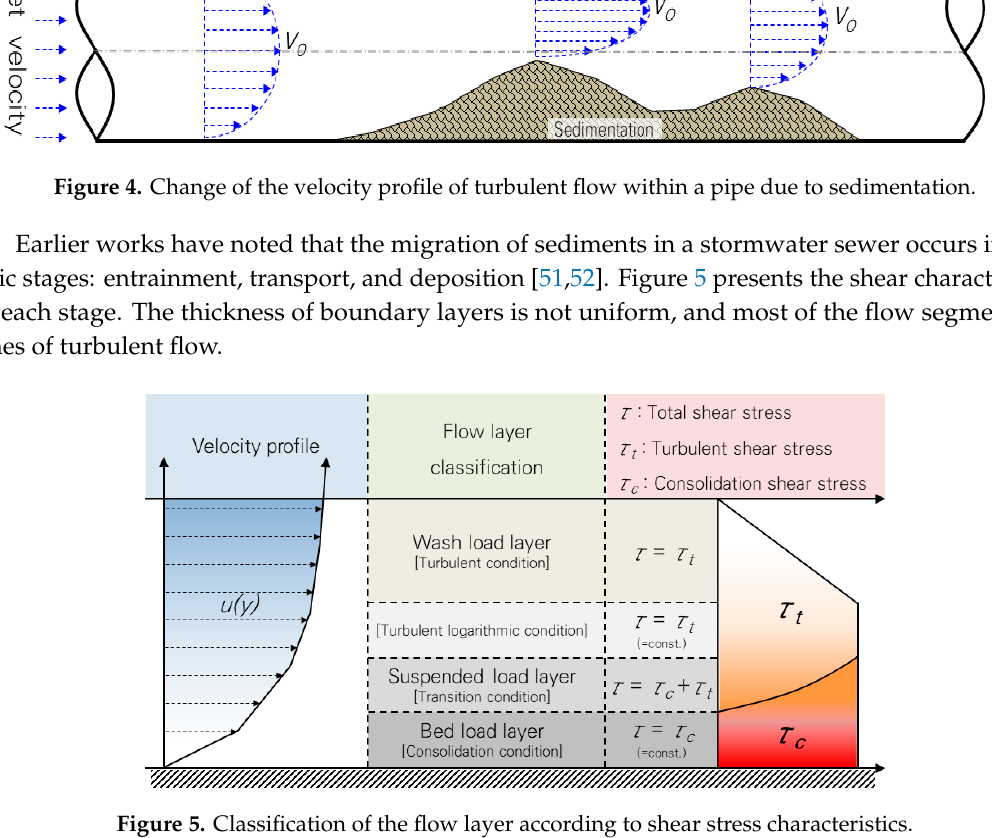
Figure 5. Classification of the flow layer according to shear stress characteristics. Table 2. Flow conditions and sediment transport status [53].